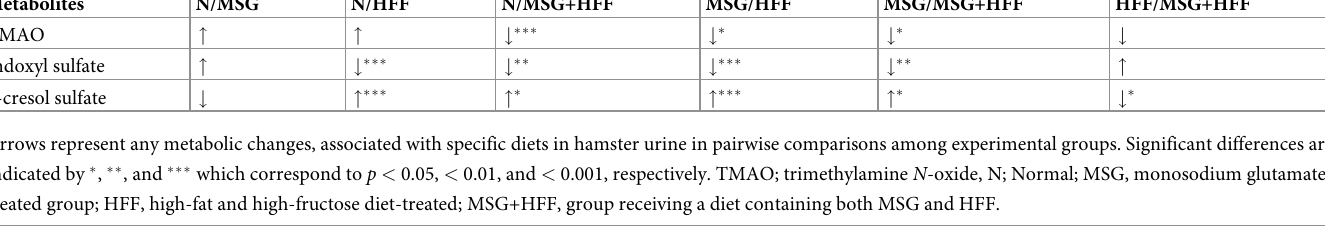
Table 1. Pairwise comparisons of differentially produced urine metabolites among experimental groups. Metabolites